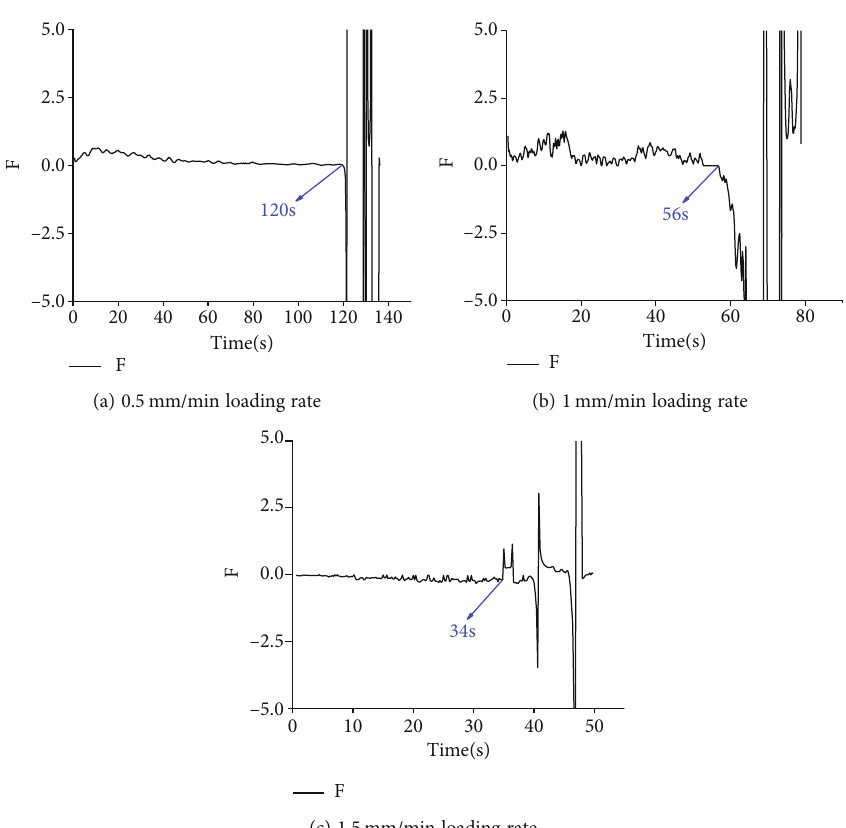
Figure 14: The variation curve of the F value under di ff erent loading